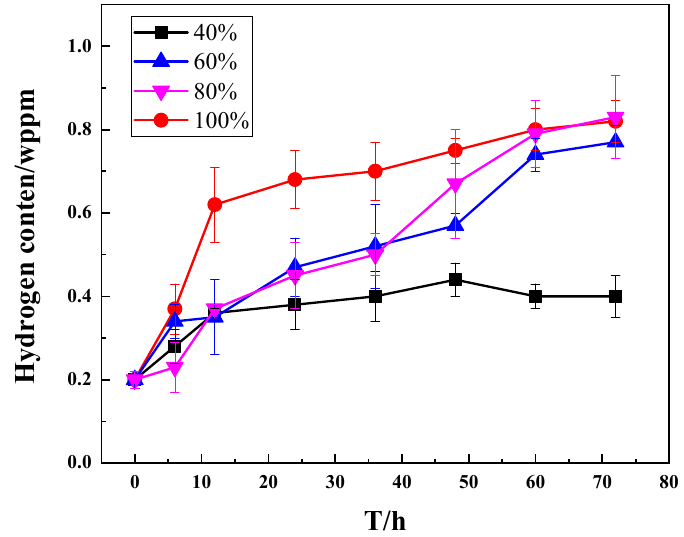
Figure 4. Hydrogen concentration over time after exposure to different humidity conditions for M7B.